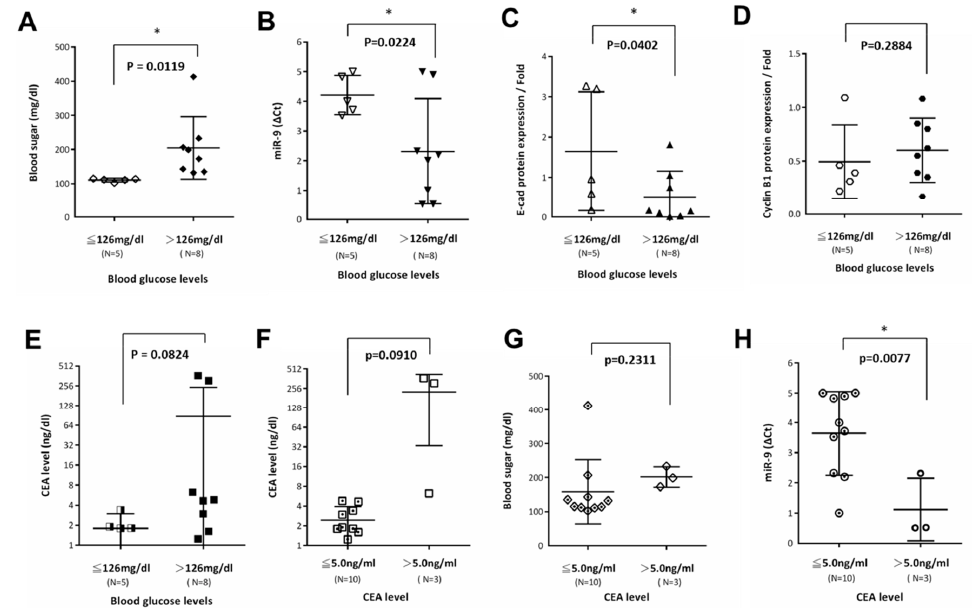
Figure 6. E-cadherin is a regulator targeting miR-9 that was negatively correlated with carcinoembryonic antigen (CEA) in patients with colorectal cancer (CRC) and hyperglycemia. ( A ) Average expression level of blood sugar was upregulated in CRC tissues in the hyperglycemia group (>126 mg/dL, n = 8). ( B ) Average expression level of miR-9 was downregulated in CRC specimens in the hyperglycemia group (>126 mg/dL, n = 8) as determined by quantitative real-time polymerase chain reaction (qRT-PCR). ( C ) Western blot analysis data show that the average expression of E-cadherin was also decreased in CRC specimens in the hyperglycemia group (>126 mg/dL, n = 8). ( D ) However, the average expression of cyclin B1 did not change significantly in CRC specimens in the hyperglycemia group. ( E ) Average CEA levels in the clinical data were increased in the hyperglycemia group (>126 mg/dL, n = 8) compared with the prediabetes group ( ≦ 125 mg/dL), but the difference did not reach statistical significance. ( F ) Average CEA levels were upregulated in CRC specimens with high CEA expression (CEA > 5.0 ng/mL, n = 3) but the difference did not reach statistical significance. ( G ) Average expression level of blood sugar was upregulated in CRC tissues with high CEA expression (CEA > 5.0 ng/mL, n = 3), but the difference did not reach statistical significance. ( H ) Average expression level of miR-9 was downregulated in CRC specimens with high CEA expression (CEA > 5.0 ng/mL, n = 3) as determined by qRT-PCR. These data show that the effect of miR-9 expression was negatively correlated with the average expression of CEA in CRC specimens.